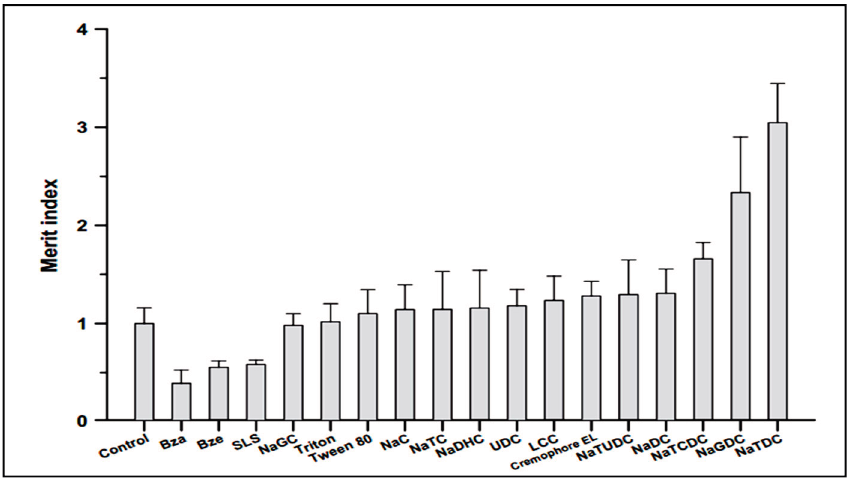
Figure 3. Effect of various surfactants on the Merit index of sCT.SLS: sodium lauryl sulfate, Bza: benzalkonium chloride, Bze: benzetonium chloride, NaGC: sodium glycocholate, NaC: sodium cholate, NaTC: sodium taurocholate, NaDHC: sodium dehydrocholate, UDC: ursodeoxycholate, LCC: lauroylcarnitine chloride, NaTUDC: sodium